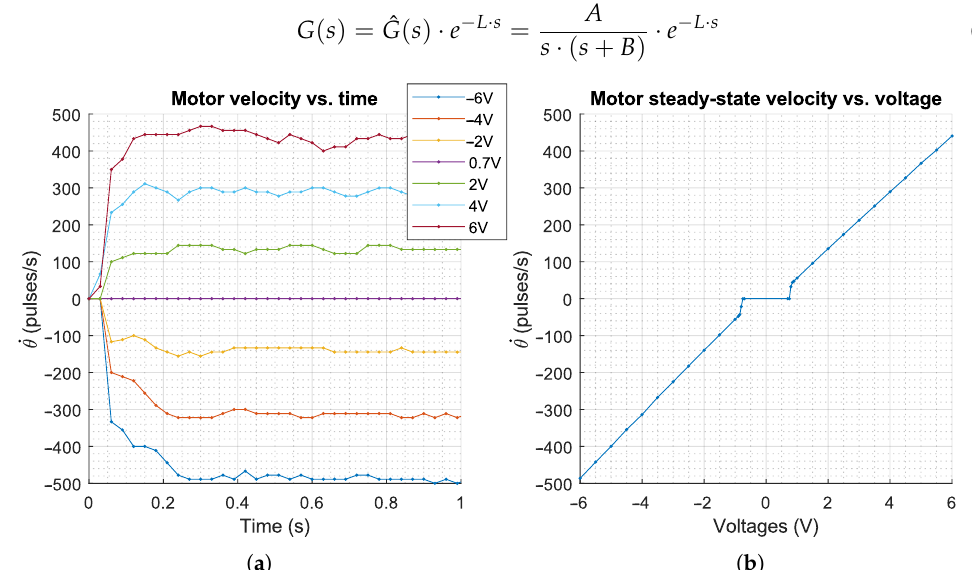
Figure 3. Identification results for front-left motor: ( a ) motor angular velocity against time for some input voltage steps; ( b ) steady-state motor angular velocity against voltage supplied for a complete